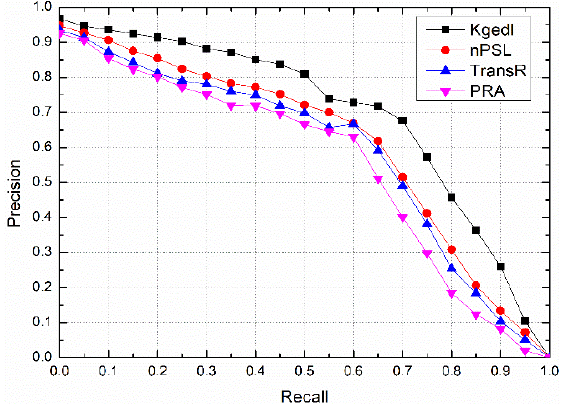
Figure 3. The recall rate precision comparison results between Kgedl and baseline methods on the IMDB dataset. IMDB dataset.